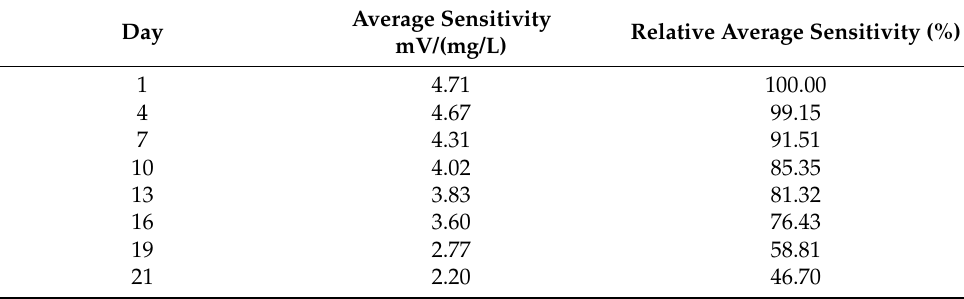
Figure 15. Lifetime of the AgNW–uricase/rGO/NiO uric acid biosensor. Table 4. Average sensitivity of the uric acid biosensor, dependent on storage time.